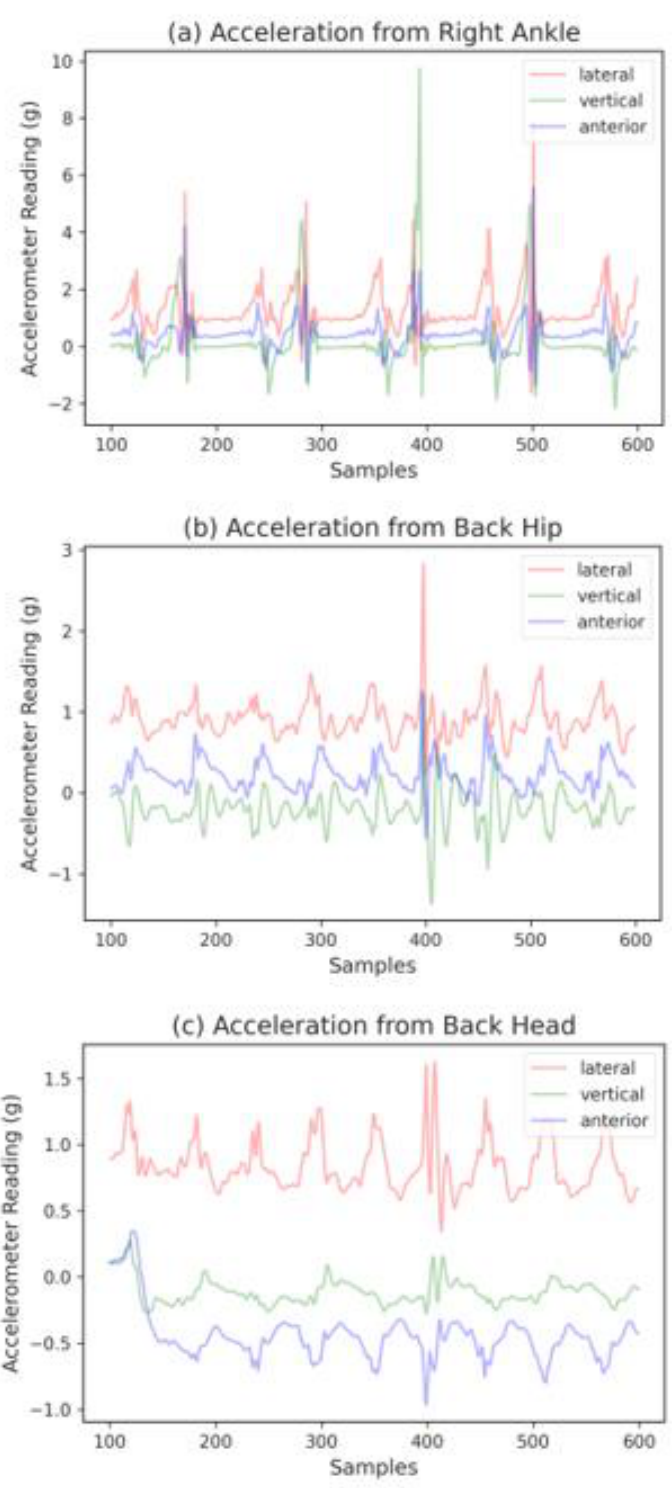
Figure 4. Five- second raw walking acceleration data of a subject measured by sensors placed at the right ankle, the back of the hip, and the back of the head.